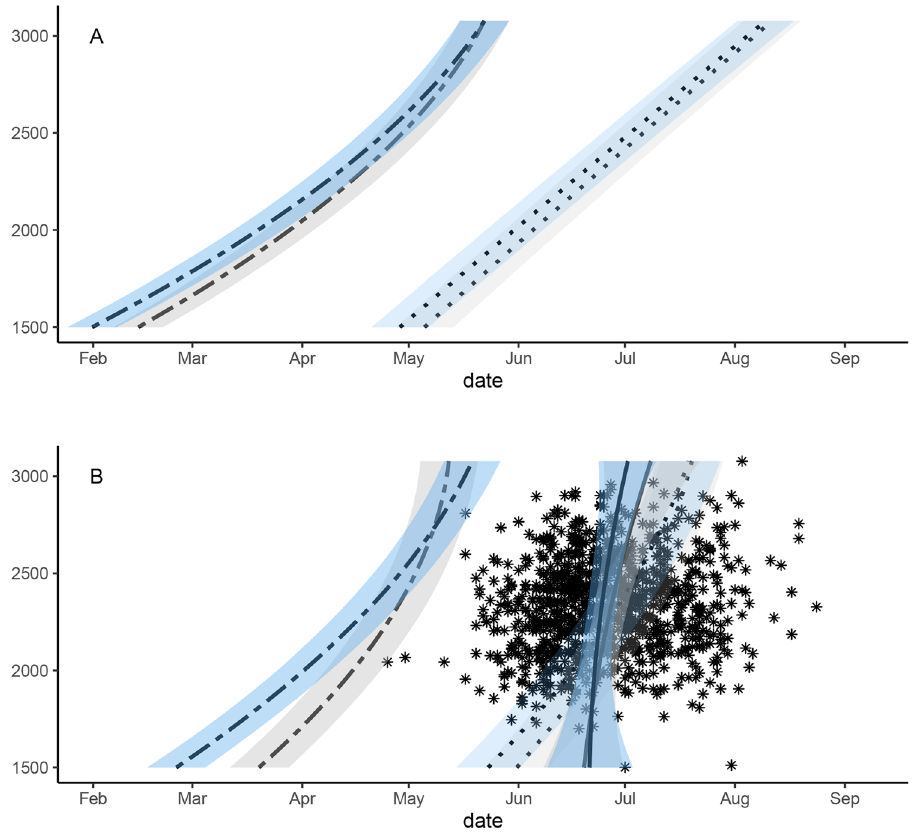
Figure 2. Mean dates for snowmelt initiation (twodash), snowmelt completion (dotted) and snowfinch hatching dates (solid) along the elevational gradient for 1999 (grey) and 2018 (blue), based on all snowfinch data with snowmelt estimated based on a complete dataset of Swiss kilometre grid cells between 1500 and 3100 m (A) and those with snowfinch observations (B) . Shaded areas represent 95% Bayesian compatibility